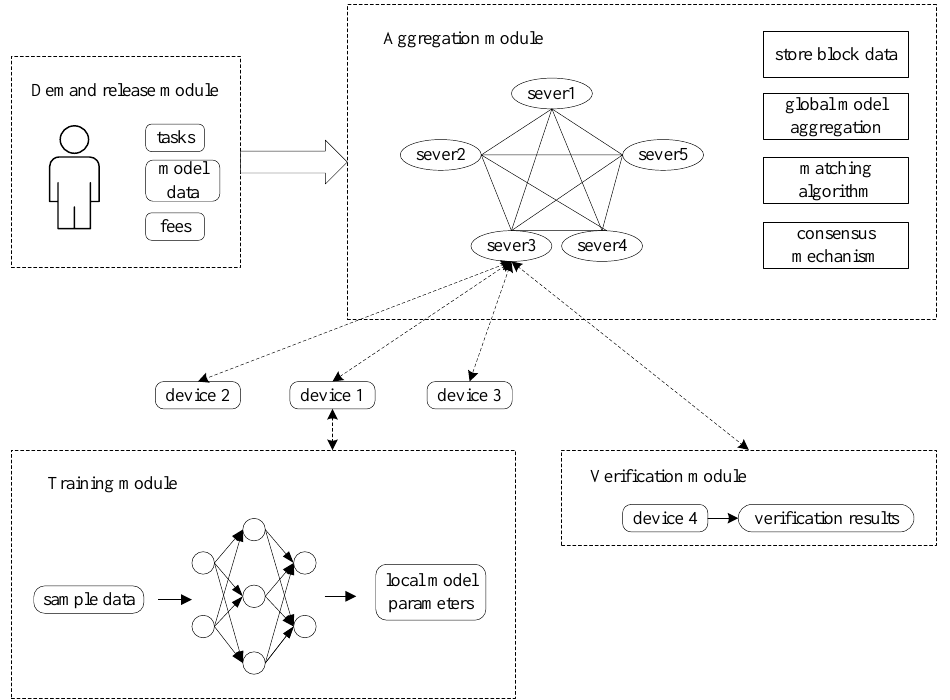
Figure 1. Architecture diagram of the decentralized federated